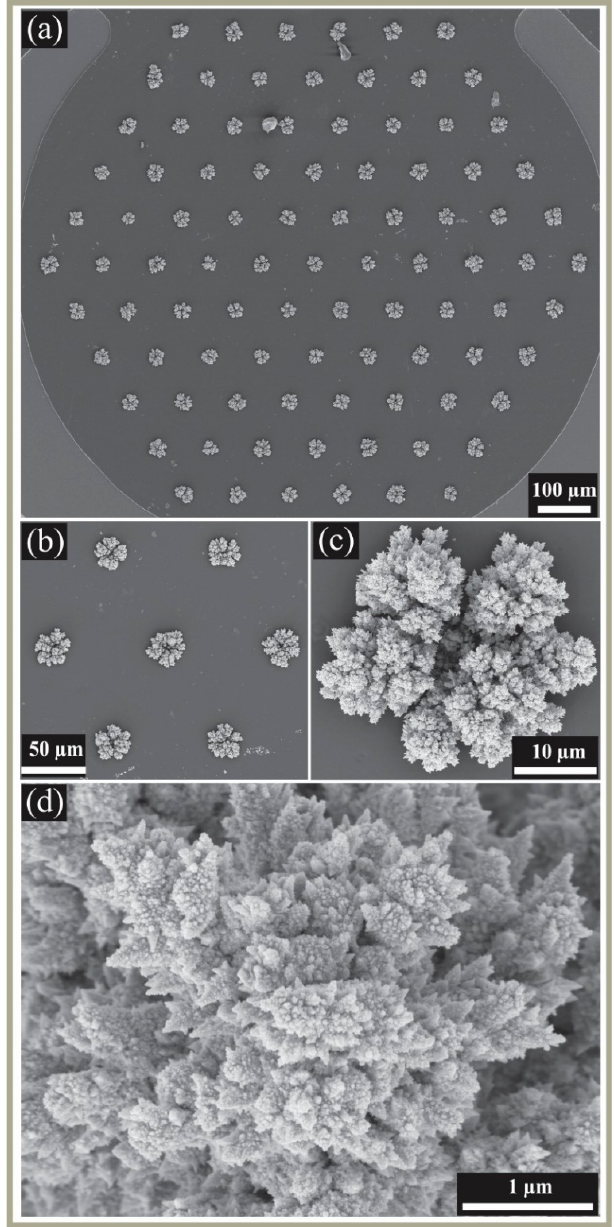
Figure 1. Scanning electron microscopy (SEM) images for Pt 3D nanostructure decorated Microarray thin-film electrodes (MATFEs) using 300 s deposition at − 0.2 V from 20 mM H 2 PtCl 6 in the presence of 2 mM Pb(OAc) 2 , showing ( a ) the whole electrode (90 electrodes, with deposits of diameter 27 ± 0.6 µm), ( b ) zoomed-in image of seven deposits, ( c ) single dendritic shaped 3D nanostructure, and ( d ) zoomed-in image showing the fine structural detail.